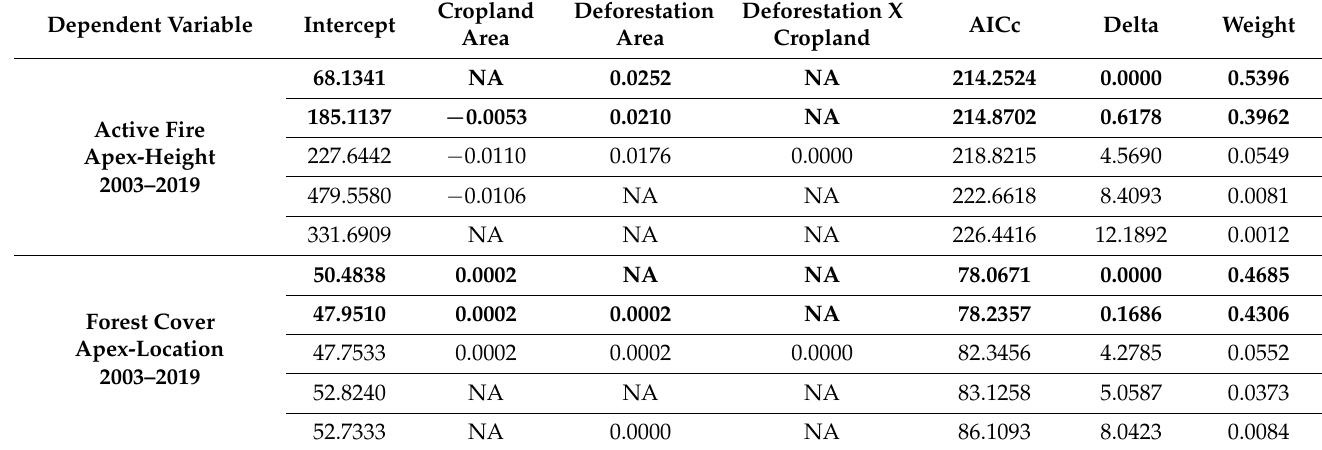
Table A1. Predicted models for the active fire apex-height and forest cover apex-location models. These analyses considered deforestation rates and cropland area as independent variables. The results are ranked by the AIC of each function.